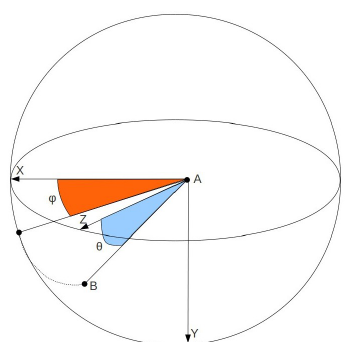
Figure 8. Trajectory angles.